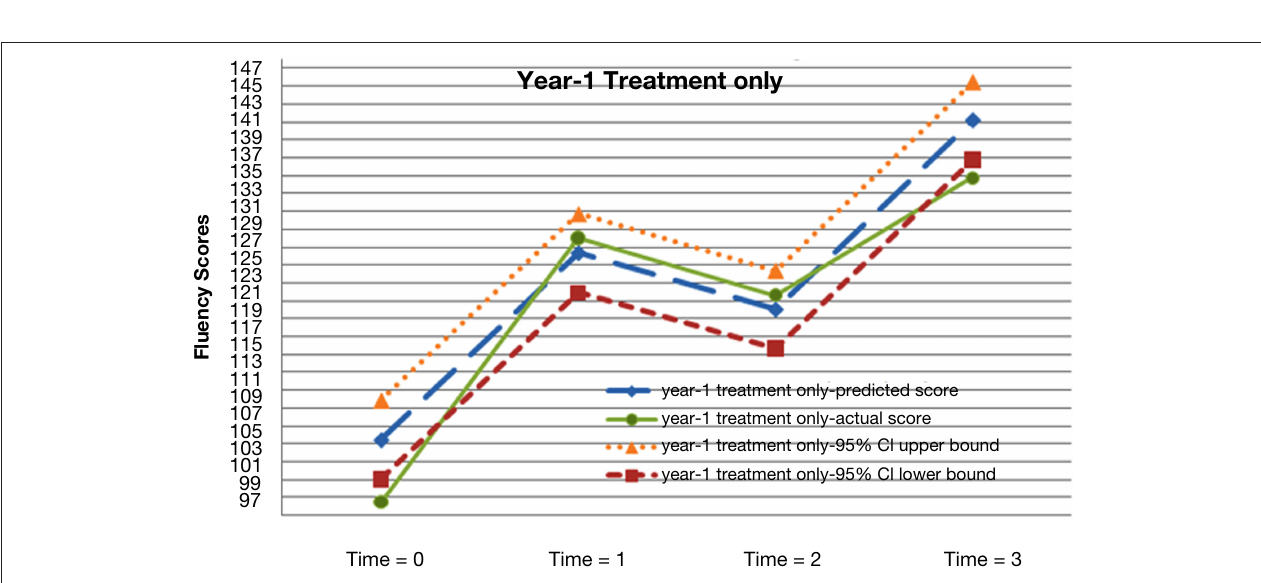
Figure 2 | Actual and predicted growth trajectories for students who never received the treatment as well as 95% confidence intervals around the predicted growth trajectories.